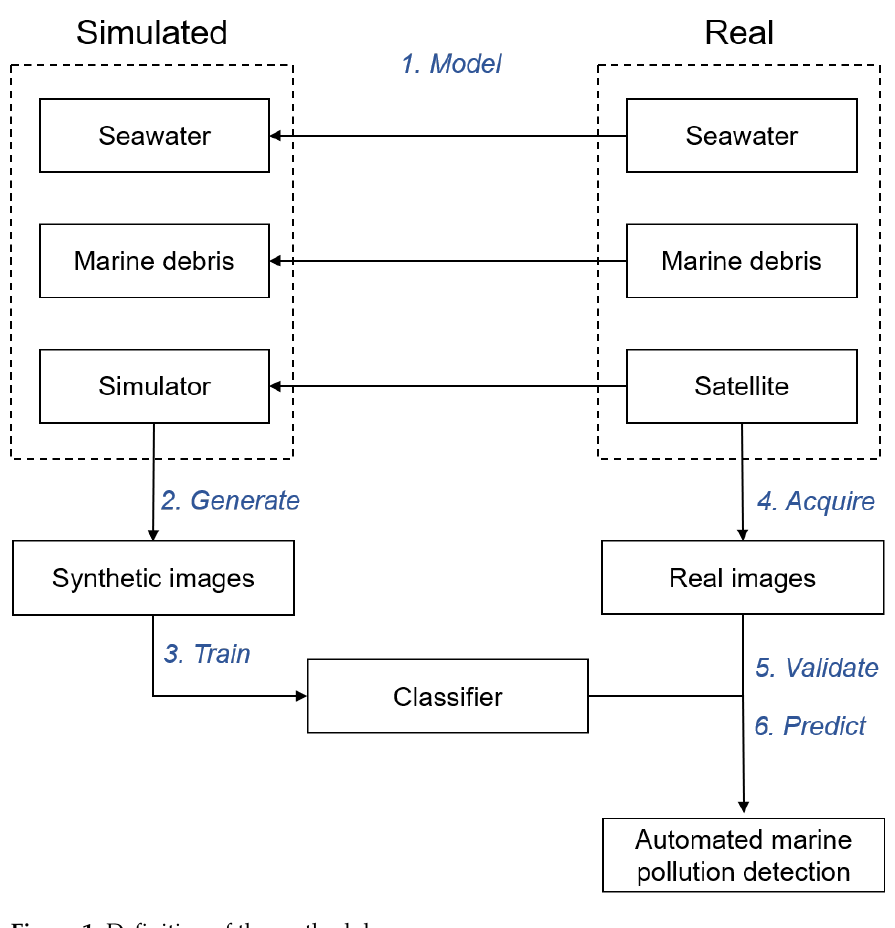
Figure 1. Definition of the